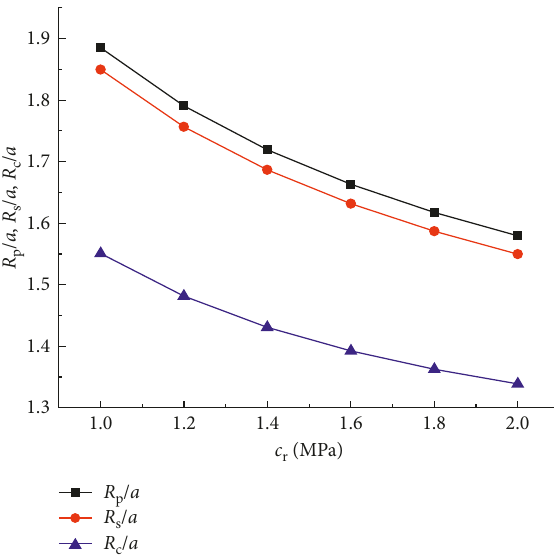
Figure 8: The values of R